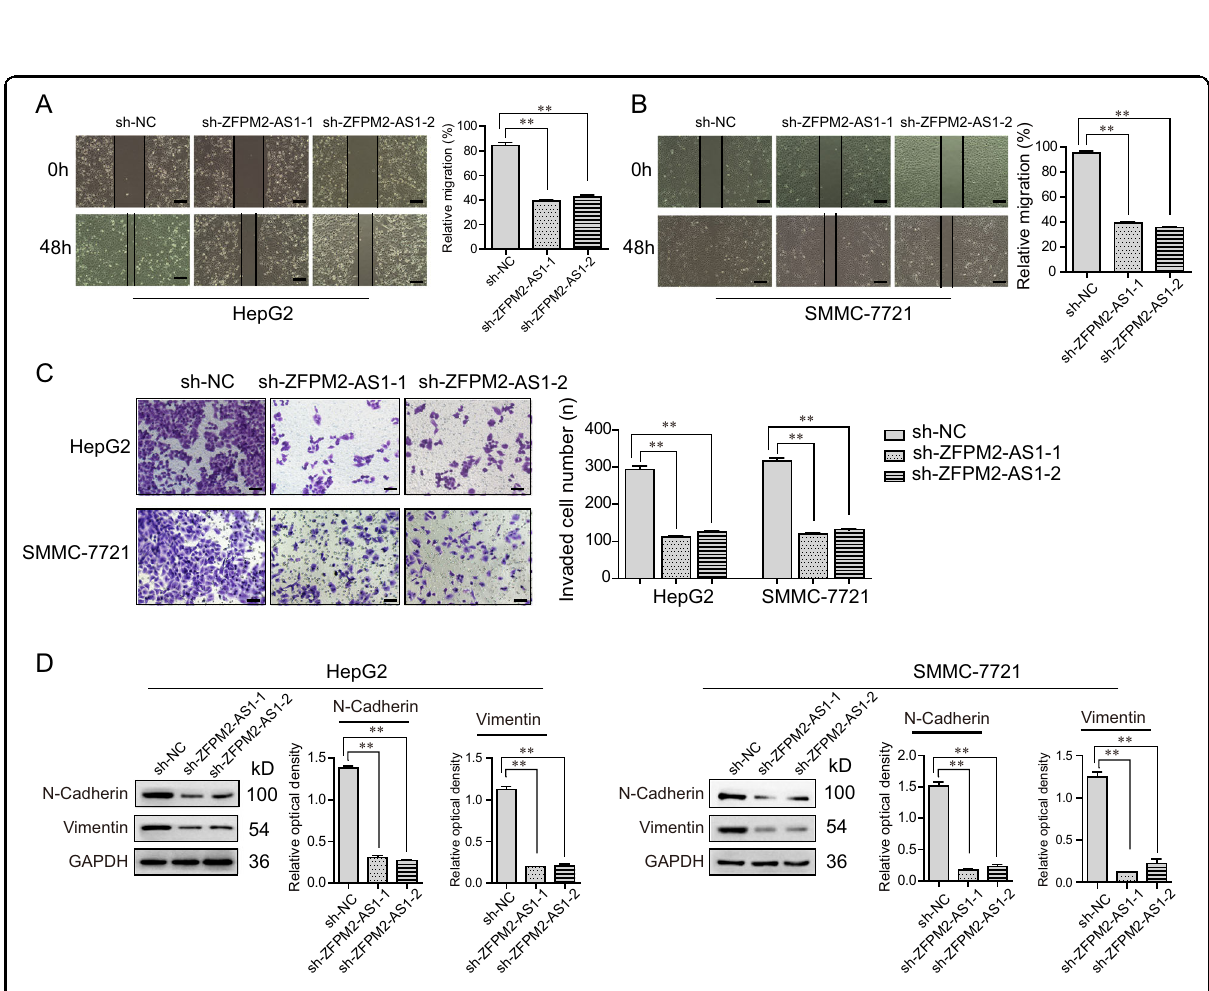
Fig. 5 ZFPM2-AS1 promoted cell metastatic properties by affecting EMT in HCC cells. A , B The migration abilities were evaluated in HCC cells infected with sh-ZFPM2-AS1-1 or sh-ZFPM2-AS1-2 lentivirus, by wound-healing assays. Scale bar = 50 μ m. C Transwell assays detected the invasion capacities of HCC cells after ZFPM2-AS1-2 depletion. Scale bar = 50 μ m. D Western blot examined the protein levels of N-cadherin and vimentin in HCC cells. Data are presented as the mean ± SD from three independent experiments. * P < 0.05, ** P <